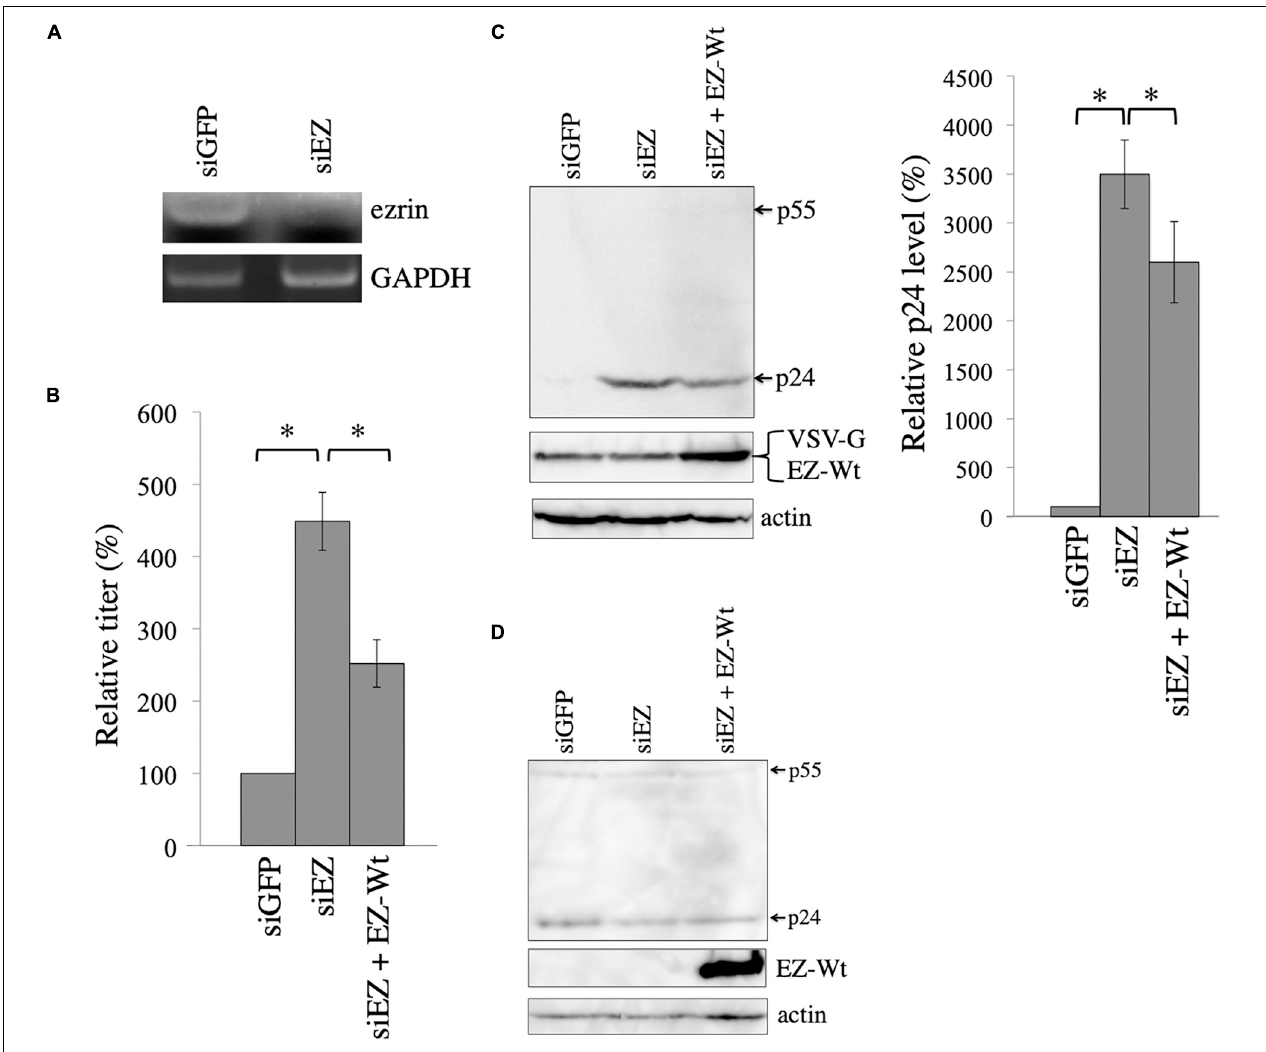
FIGURE 5 | Ezrin silencing elevates HIV-1 Gag protein level. (A) COS7 cells were transfected with the VSV-pseudotyped HIV-1 vector construction plasmids together with siGFP or siEZ. Total RNA samples were isolated from the transfected cells. GAPDH and ezrin mRNA levels were analyzed by semi-quantitative RT-PCR. (B) Culture supernatants from the transfected cells were inoculated to target cells, and transduction titers were measured. Relative values to the transduction titers in siGFP-transfected cells are indicated ( n = 3). Asterisks show significant differences between the indicated groups. (C) Cell lysates prepared from the transfected cells were analyzed by western blotting. HIV-1 Gag precursor (p55), mature capsid (p24), and EZ-Wt proteins were indicated (left panel). Intensities of p24 protein were measured by a densitometer. Relative values to the intensities in the siGFP-transfected cells are shown (right panel, n = 3). Asterisks show significant differences between the indicated groups. (D) COS7 cells were transfected with HIV-1 HXB2 Env-containing HIV-1 vector construction plasmids together with siGFP or siEZ. Cell lysates from the transfected cells were analyzed with western